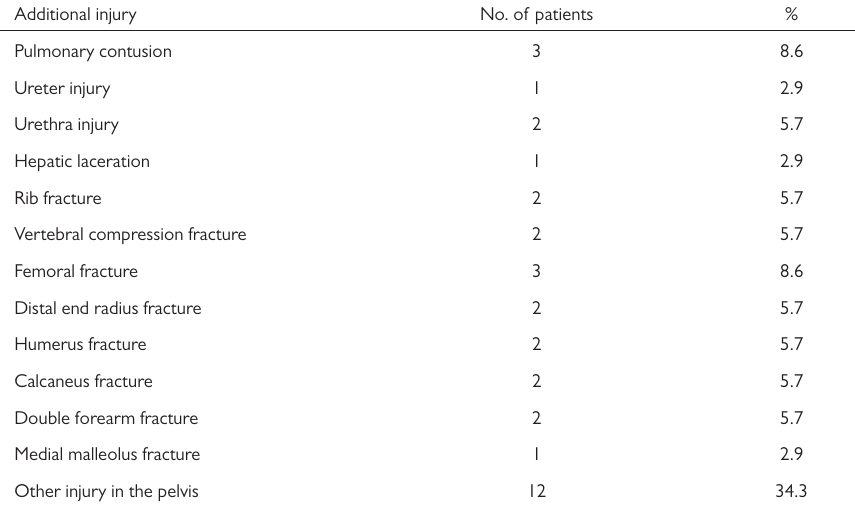
Table 1. Additional injuries observed in patients with acetabulum fractures Additional injury